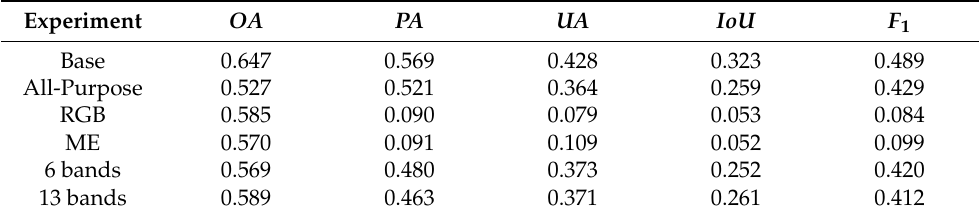
Table 16. Global metrics for the experiment with UNet on UOS2. Experiment